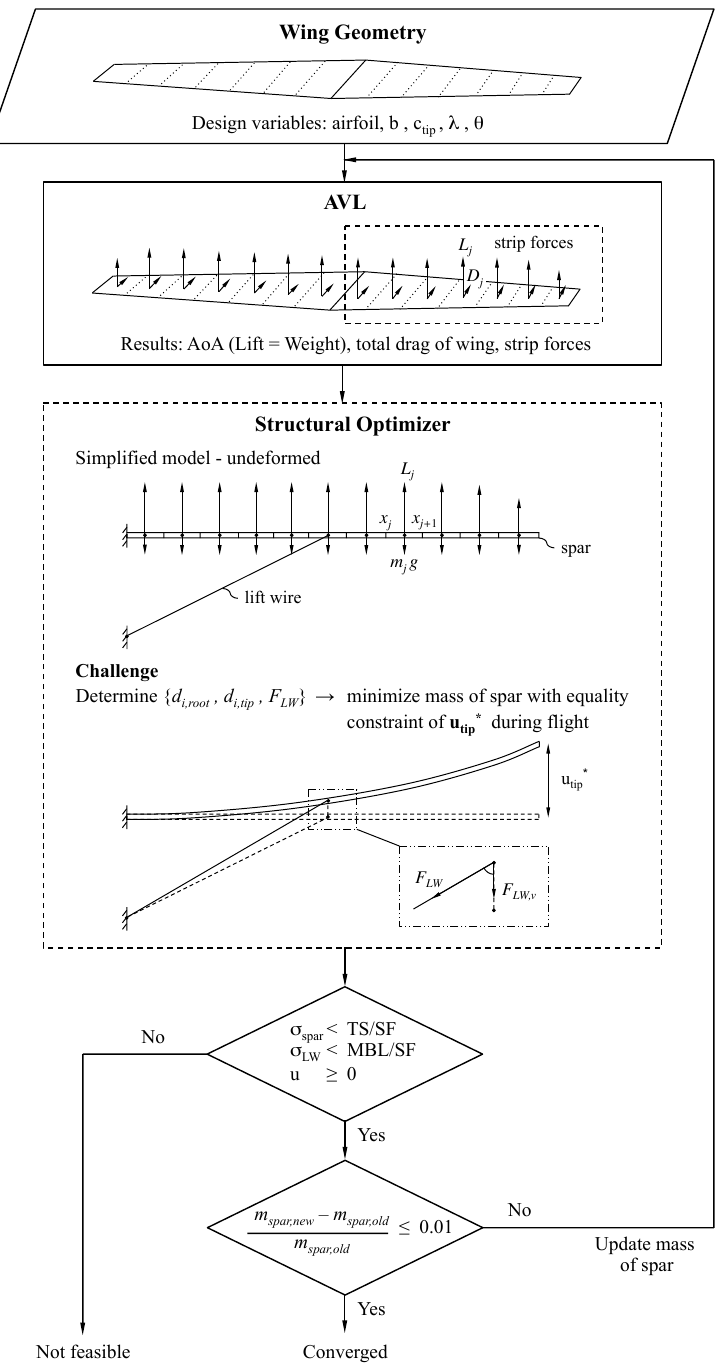
Figure 13. Structural optimization